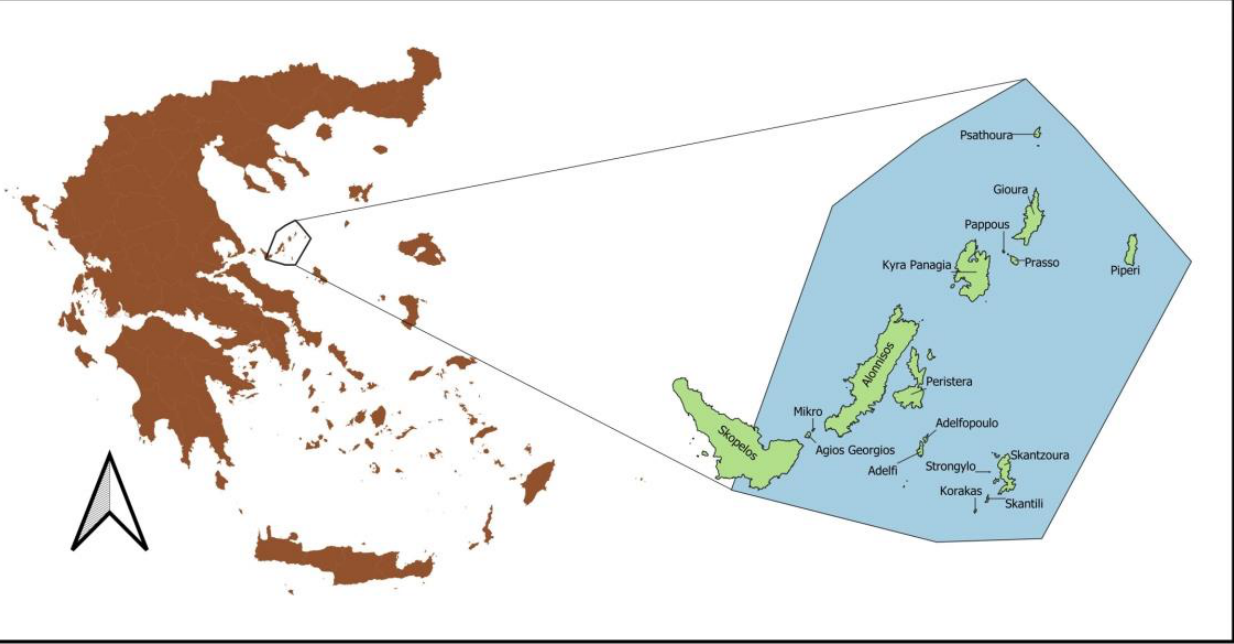
Figure 1. The study area is in the Aegean Sea, Greece and is part of the network of protected areas established by the EU, NATURA 2000 with site code GR1430004. Includes the National Marine Park of Alonissos and Northern Sporades.